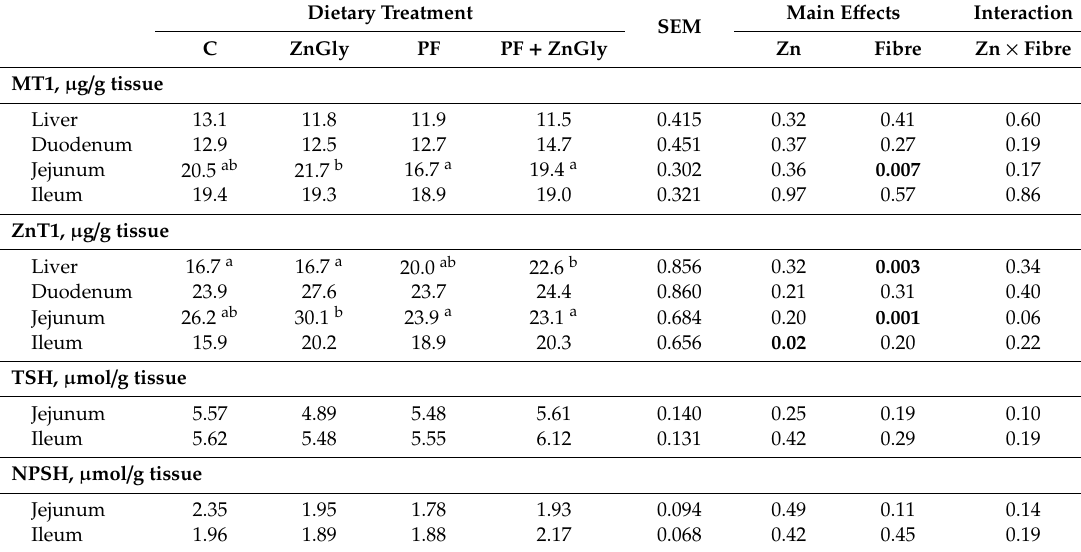
Table 2. The tissue concentration of the metallothein 1 (MT1), zinc transporter 1 (ZnT1), and total and non-protein-bound thiols (TSH and NPSH, respectively) in piglets fed diets di ff ering in zinc and fibre source. Dietary Treatment Main E ff SEM